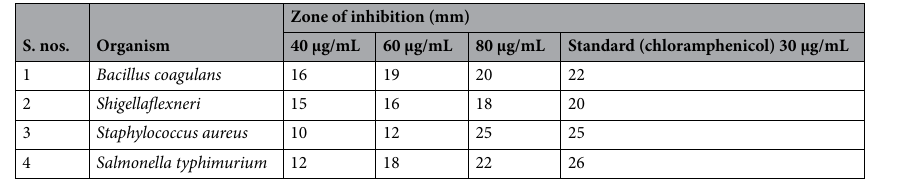
Table 3. The zone of inhibition of TANI/Cu 2 O/Ag